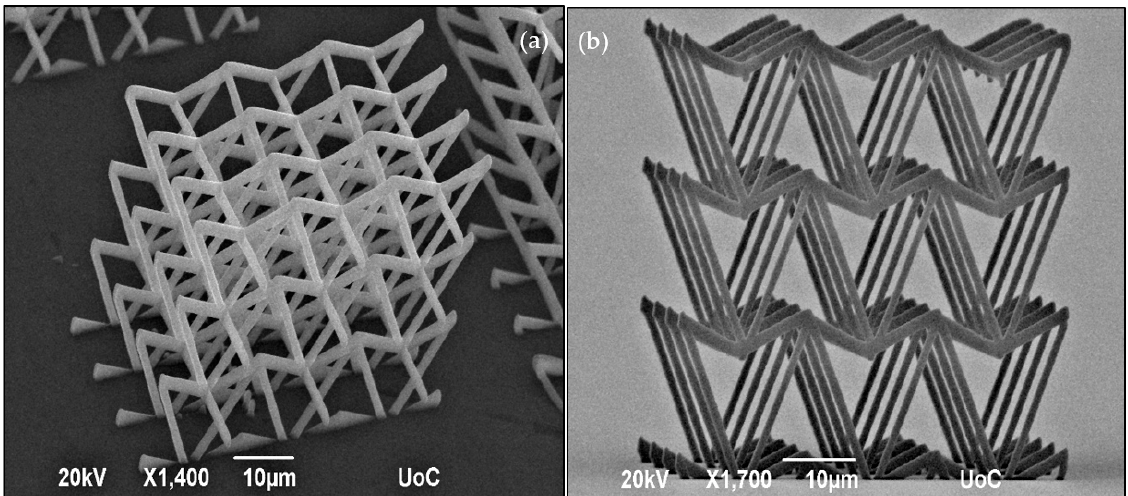
Figure 3. SEM images of the 2D tunable filter comprised of the re-entrant triangular fabricated using Nano-cube at 90 mJ/cm 2 laser fluence and 100 μ m/s scan speed. ( a ) Perspective view, and ( b ) Side view.